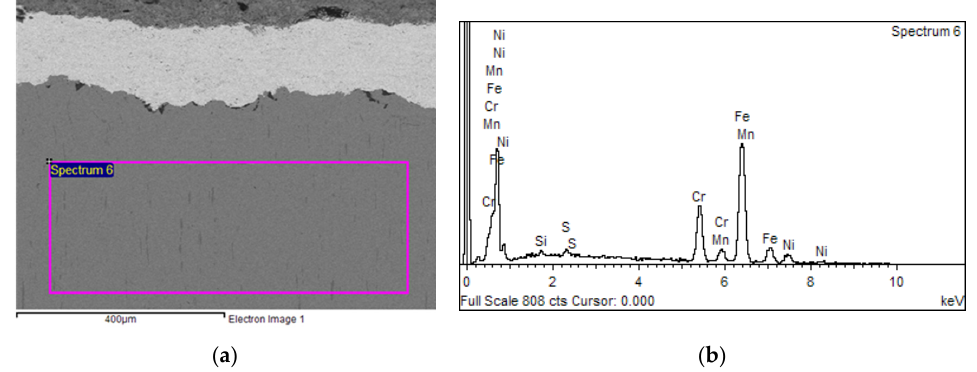
Figure 5. ( a ) SEM image of base material and coating; ( b ) EDS spectrum of selected area of base material.